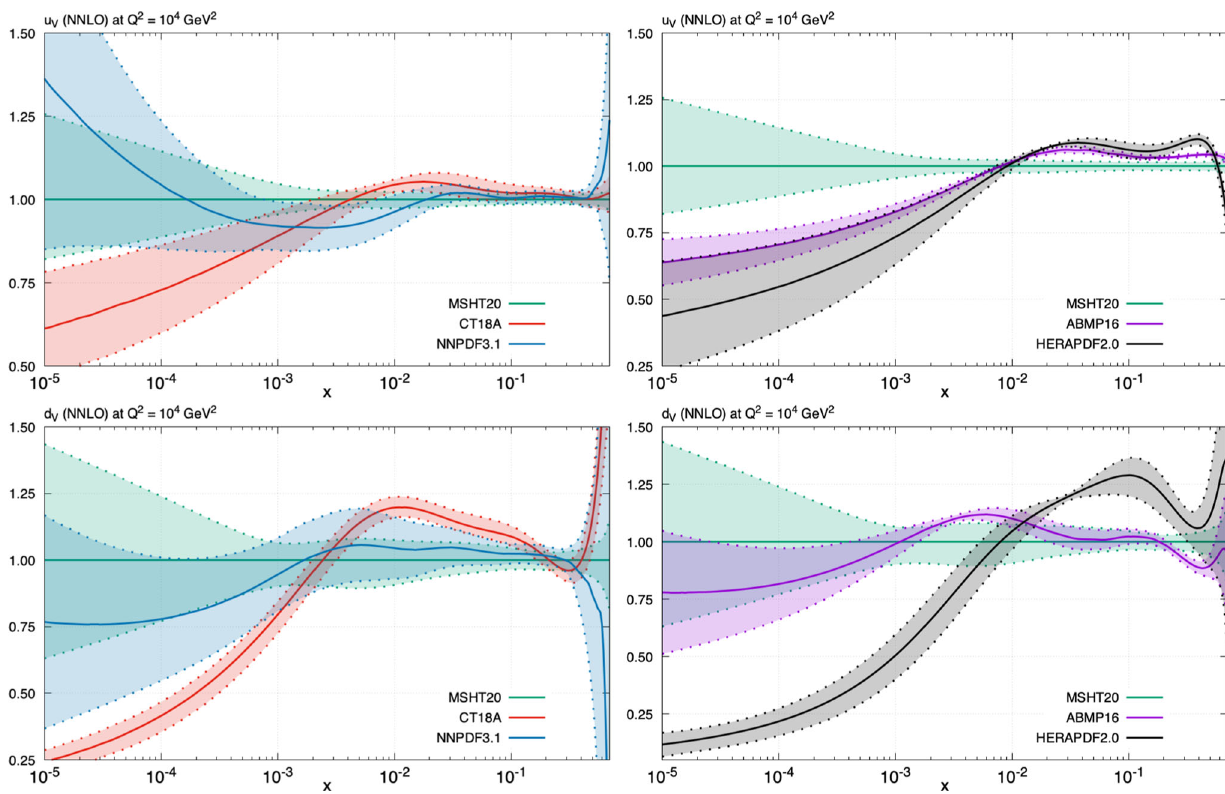
Fig. 92 Comparison of the MSHT20 NNLO up and down quark valence PDFs at Q 2 = 10 4 GeV 2 with other representative PDF sets, presented ) = 0 . 118 in all cases as a ratio to the MSHT set. These correspond to α S ( M 2 Z